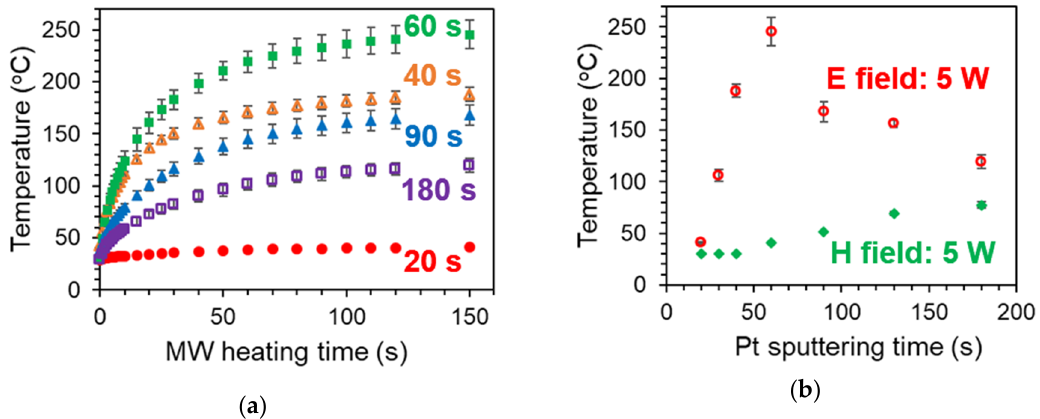
Figure 6. MW heating of 20–180 s sputtered and 300 ◦ C-calcined Pt / Al 2 O 3 substrates. ( a ) Temperature increase by MW electric field (E field) over heating time. ( b ) Temperature after 150 s heating of E field or MW magnetic field (H field). Each heating experiments were repeated by 4 times.